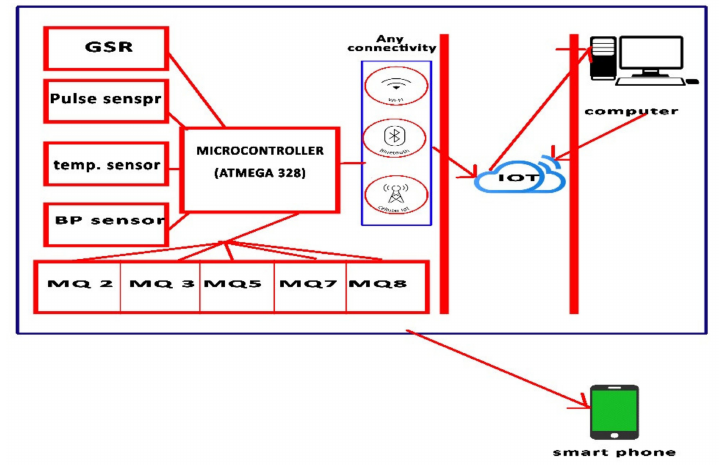
Figure 1. The block diagram of the design